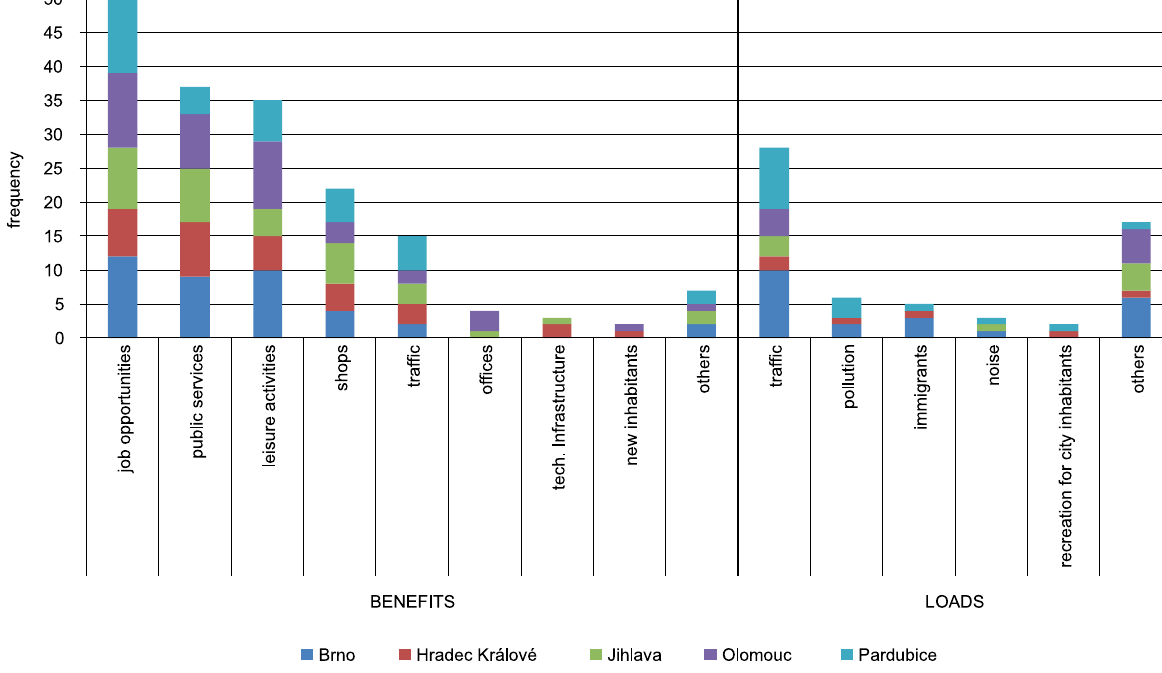
Fig. 2. Benefits and burdens of the large cities proximity for the municipalities in their hinterland. Source: Survey of 69 municipalities in the hinterland of the selected core cities, GaREP,